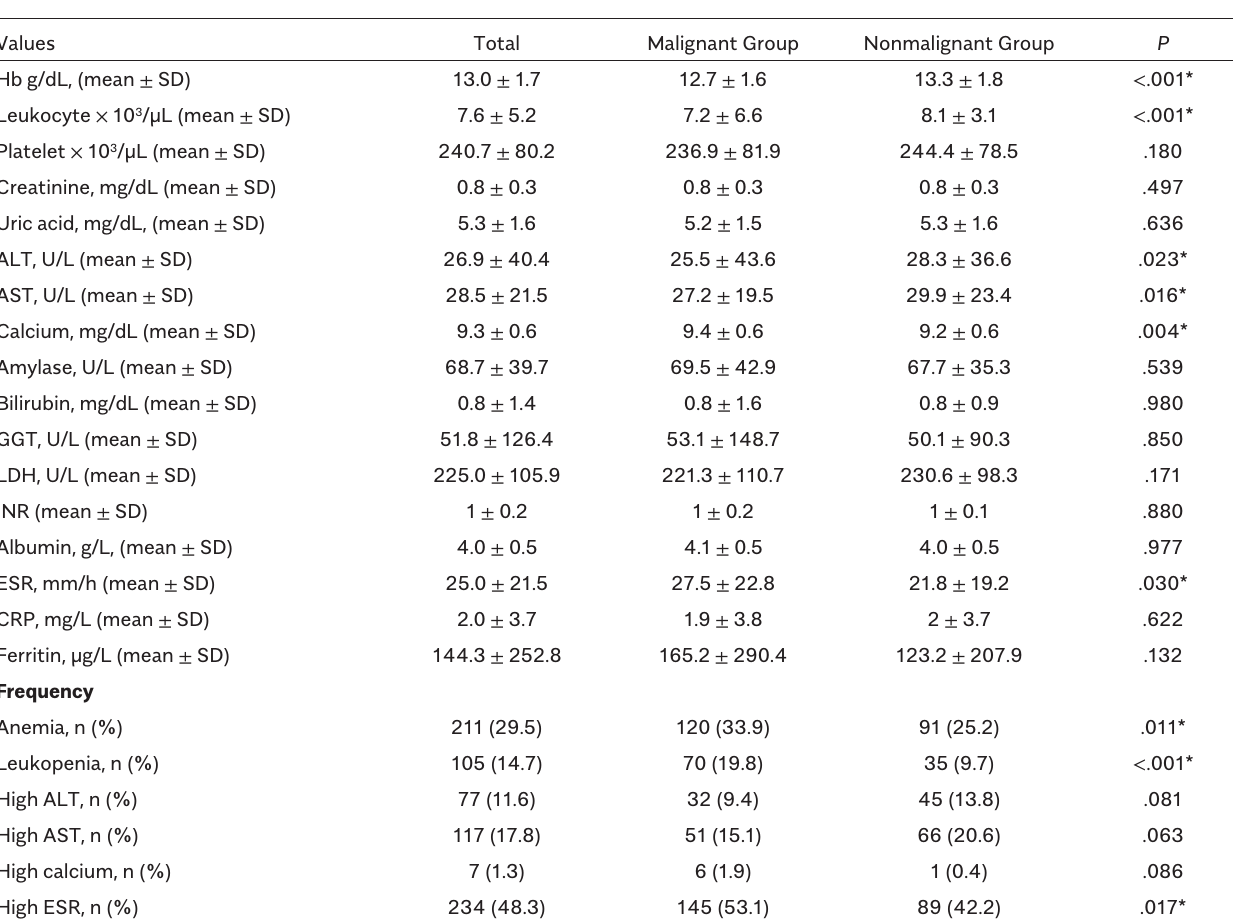
Table 4. Laboratory Results in Patients with MP Values Total